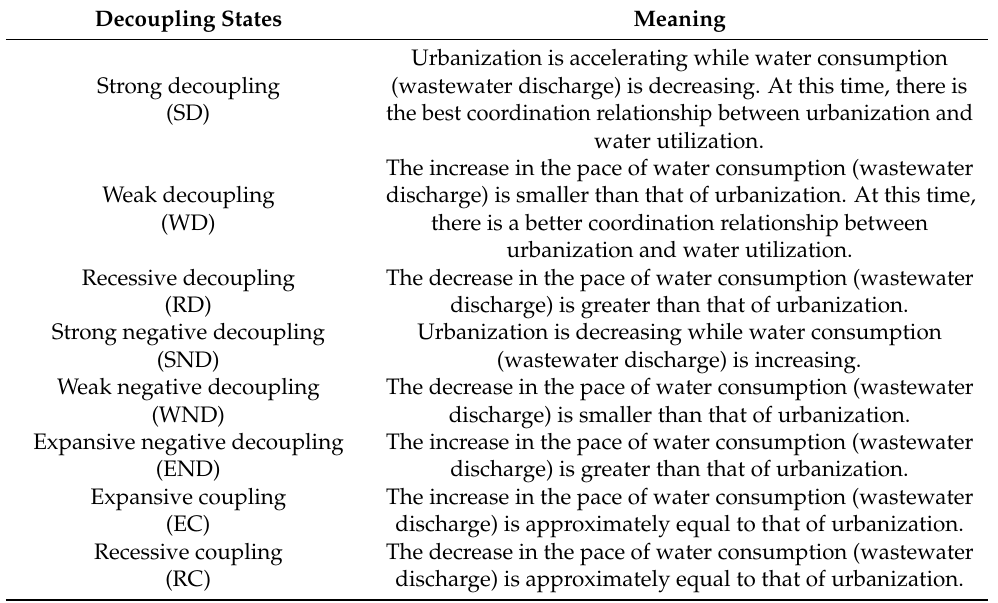
Figure 3. Classification of decoupling states in the Tapio model by referring to Zhang [48] and Kong [35]. The degree of decoupling increases along the positive direction of the ∆ SD-axis (change rate of urbanization indicators; horizontal axis) and in the negative direction of the ∆ WF-axis (the change rate of the WF; vertical axis). Table 2. The meaning of each decoupling state.